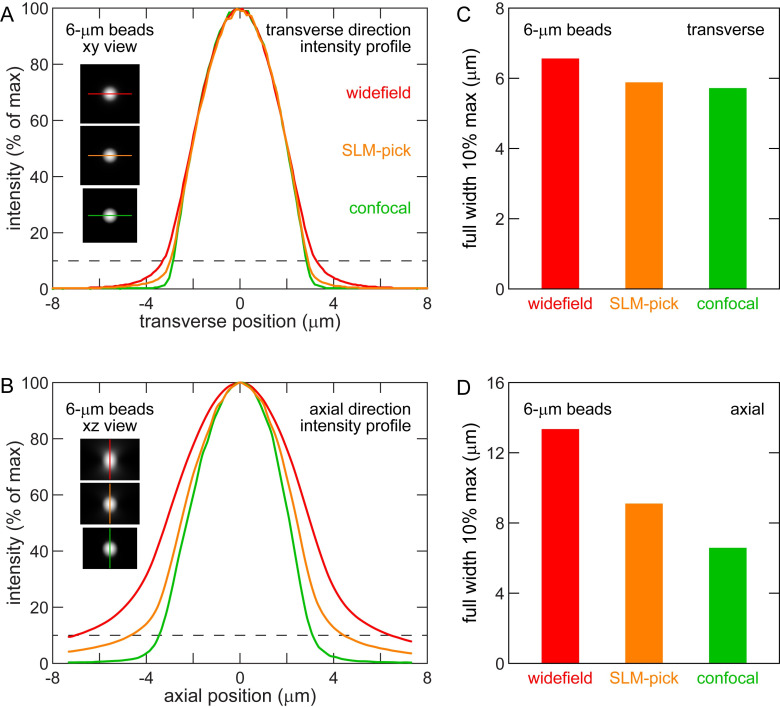
SLM improves sectioning capability of localized fluorescent source.(A) Average transverse intensity profile of 6-μm fluorescent beads. Dotted line at 10% maximum intensity. Insets show maximum projection of average bead images with profile line. (B) Average axial intensity profile of 6-μm fluorescent beads. Insets show maximum projection of average bead images with profile line. (C) Transverse full width at 10% maximum intensity in (A). (D) Axial full width at 10% maximum intensity in (B). Note improved confinement of fluorescence to true bead extent in SLM imaging compared to widefield, particularly in axial direction. n = 85 (widefield), 90 (SLM-pick), and 63 (confocal) beads.